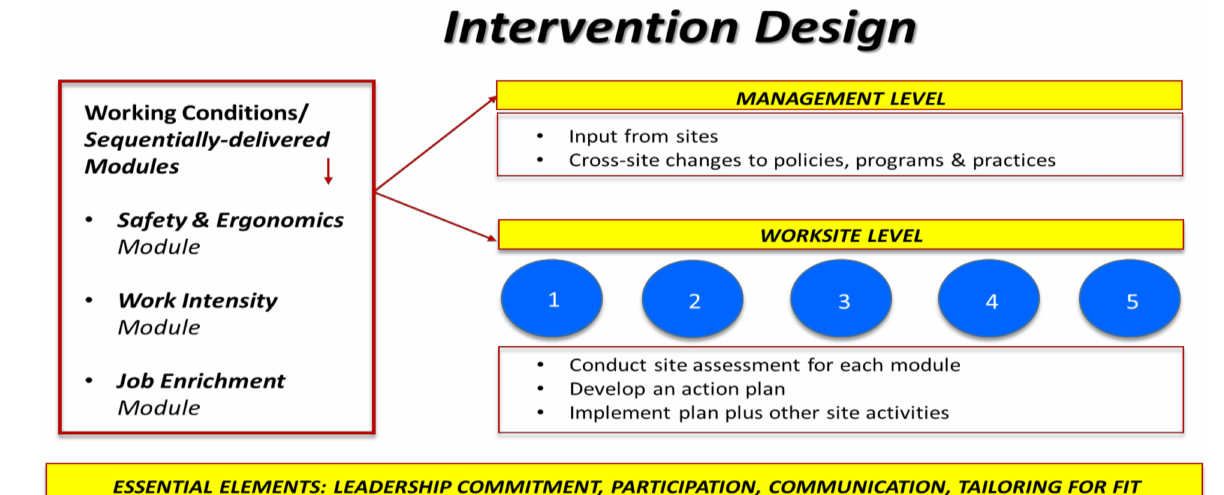
Figure 2. Organizational intervention for improving safety, health, and well-being of low-wage food service workers